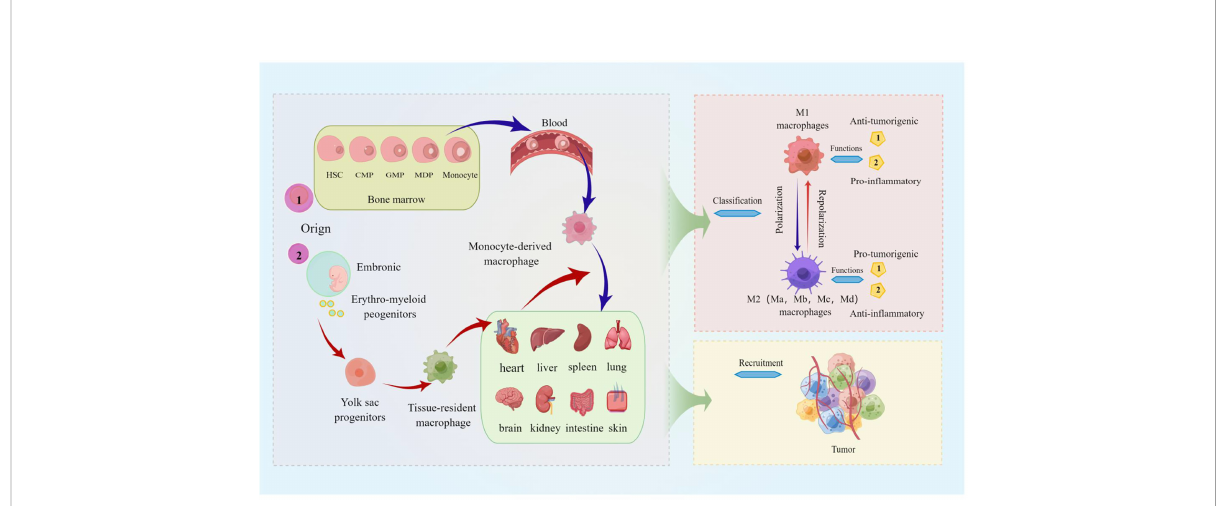
FIGURE 1 The source, function, classi fi cation, and recruitment of TAMs. The picture displayed that TAMs are derived from blood mononuclear cells from bone marrow hematopoietic stem cells, called monocyte-derived TAMs (or tumor-induced TAMs) and yolk sac progenitors, and reside in organs such as the lung, brain, liver, and skin. Macrophages polarized in tumors are divided into M1 (classically activated macrophages) and M2 (alternatively activated macrophages), and M2 macrophages can be further divided into Ma, Mb, Mc, and Md subtypes. M1 macrophages are characterized by the secretion of pro-in fl ammatory cytokines involved in anti-infective responses, and the immunosuppressive phenotype of M2 macrophages tends toward tissue repair and tumor progression; TAMs are activated by cytokines, growth factors, etc. can be recruited to tumor